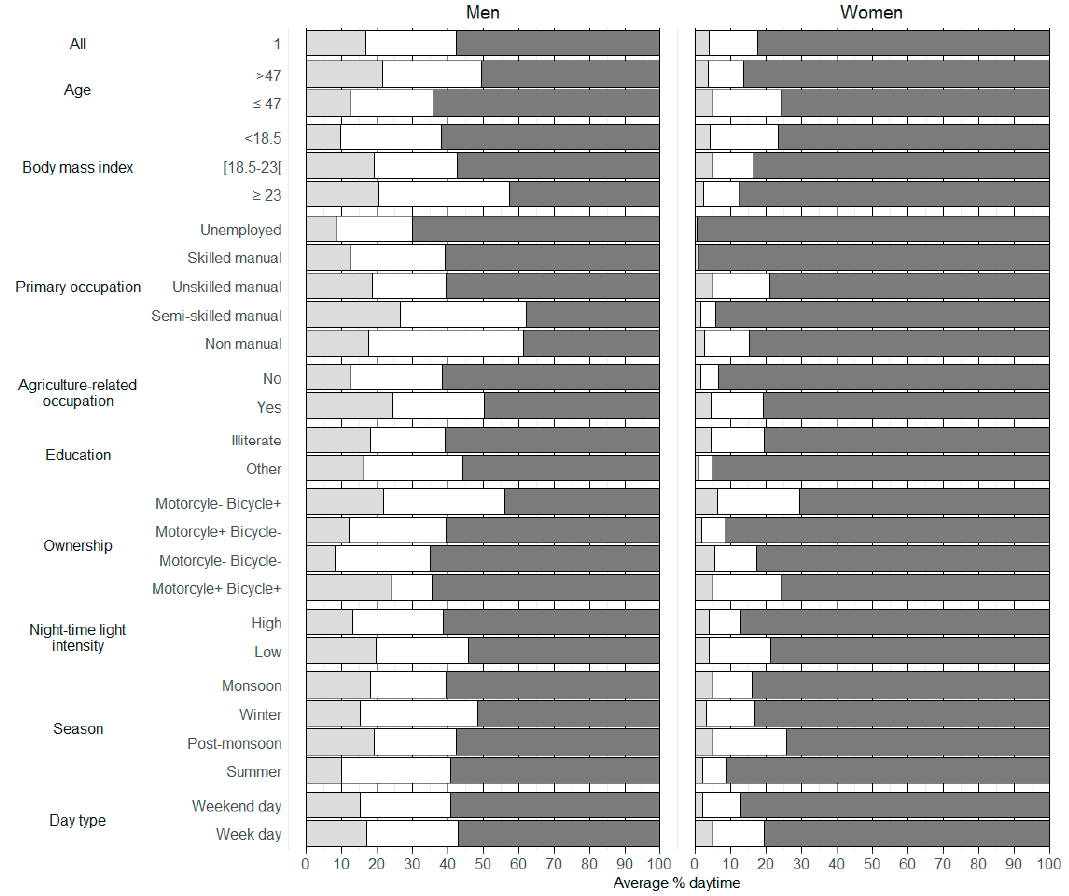
Abbreviation: GPS: Global Positioning System, m: mean, sd: standard deviation. Age calculated at May 1, 2015. Unemployment included housewifes, retired people, and unemployed people. P-values derived from ANOVA (continuous variables) or χ 2 test (categorical variables) comparing men and women.